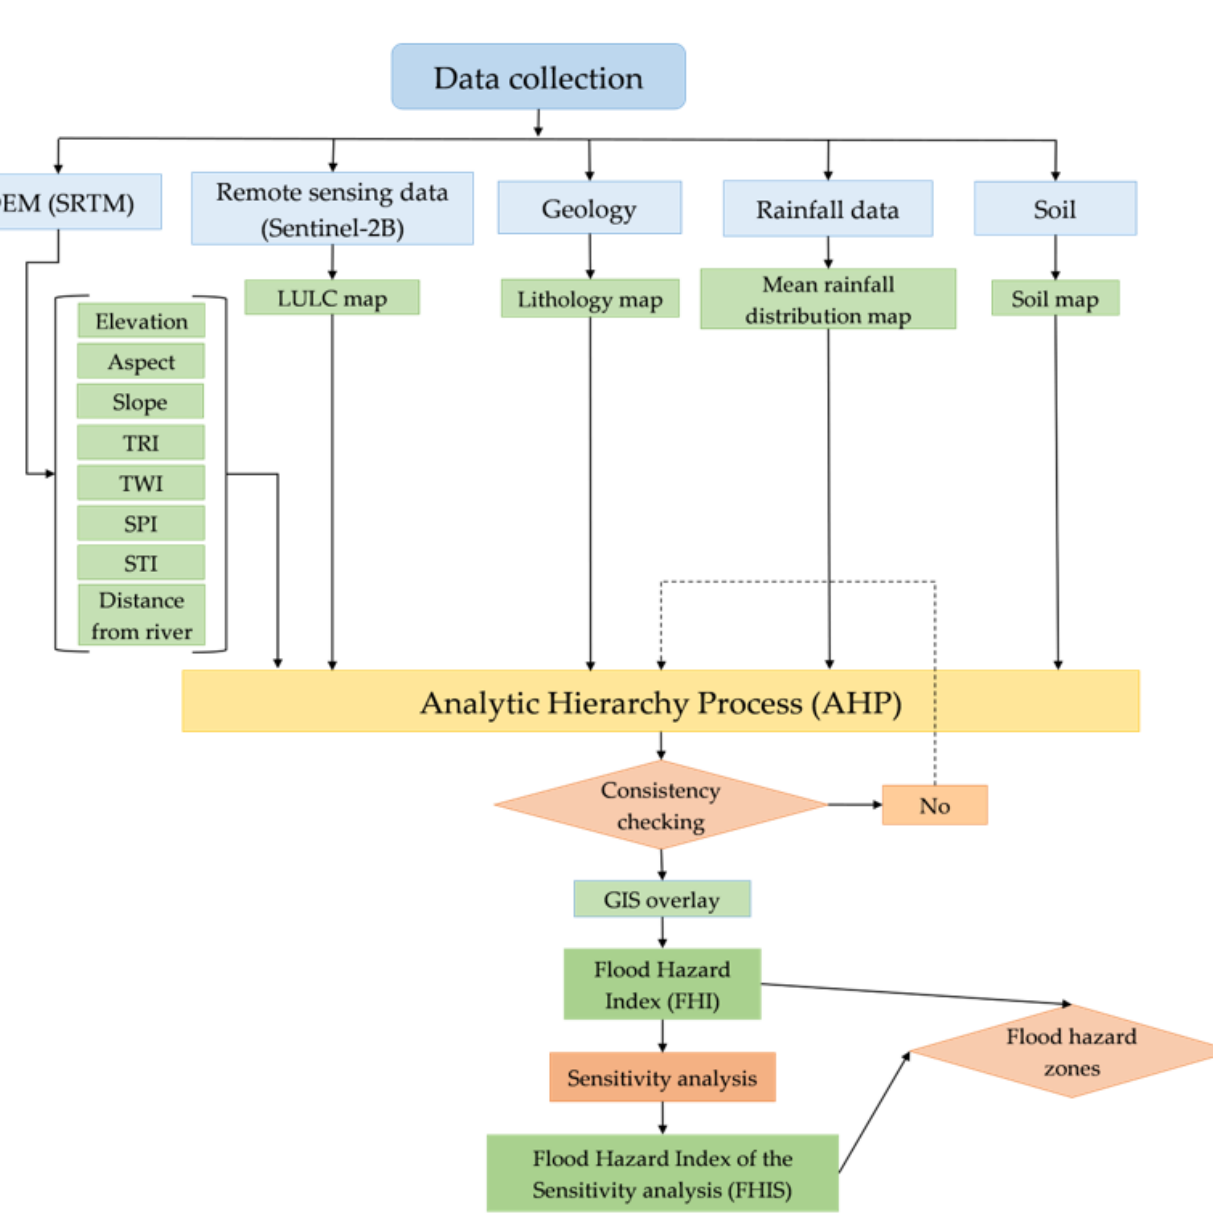
Figure 4. Workflow of AHP methodology to prepare flood susceptibility map for part of Duhok district.